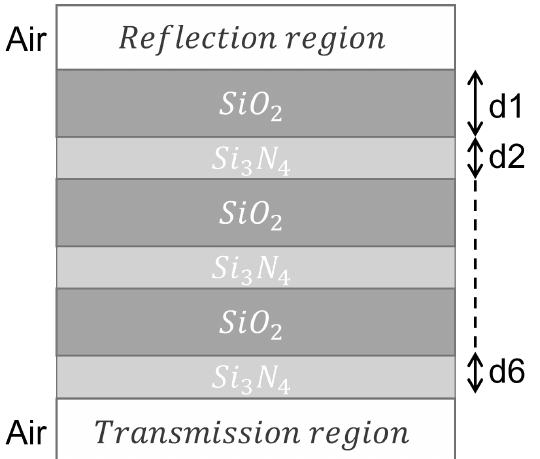
Figure 2. A 6-layer thin-film structure of alternating layers of SiO 2 and Si 3 N 4 , all of some depth d i . The transmission and reflectance media surrounding the structure are both half-infinite free